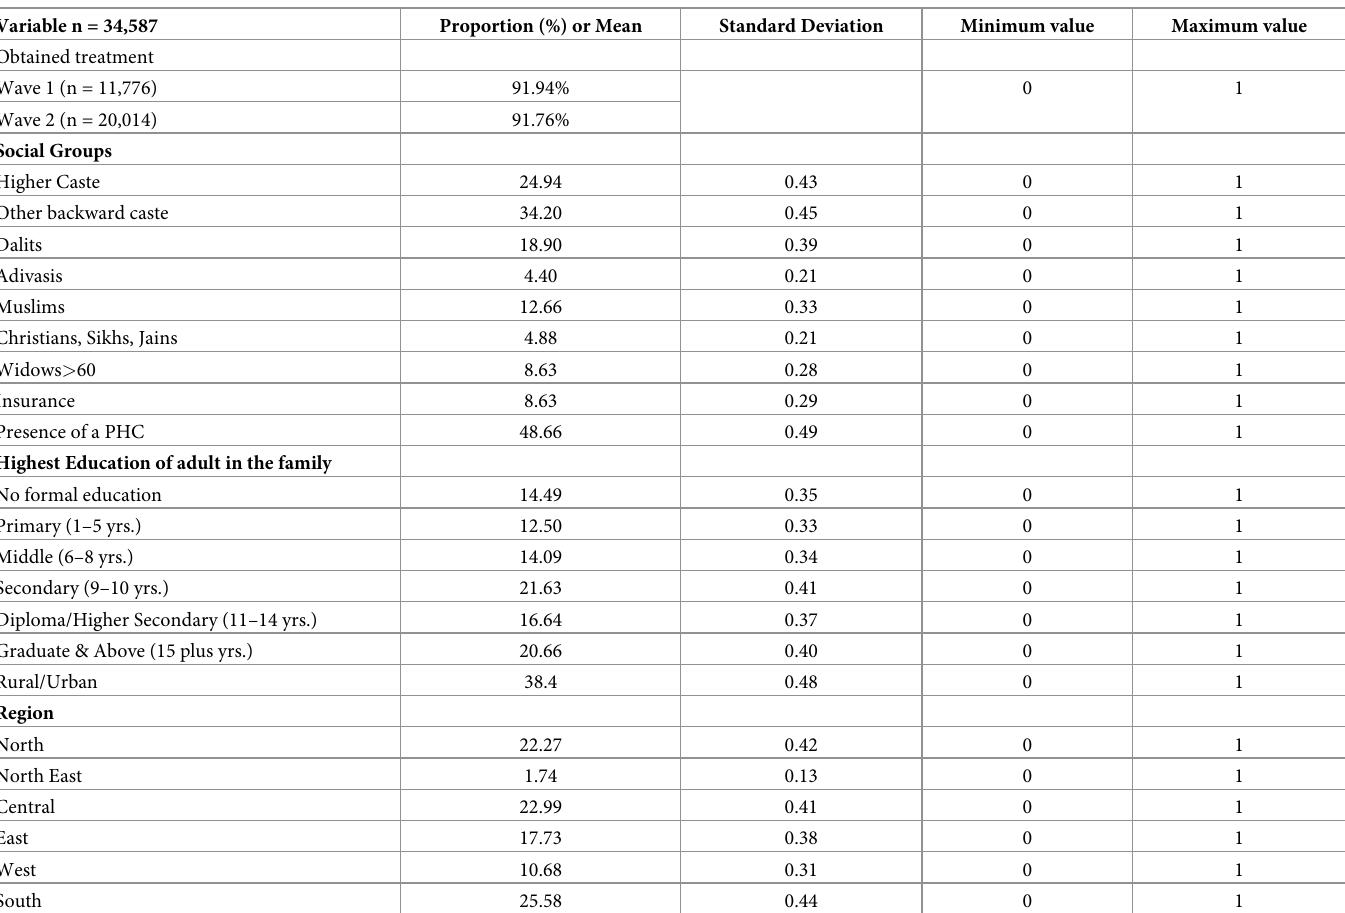
Table 1. Descriptive statistics.